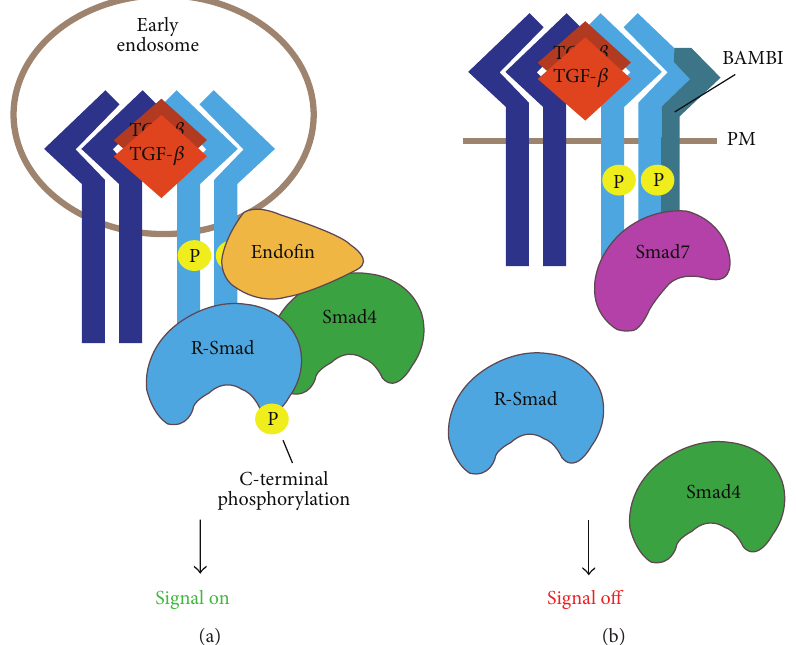
Figure 3: Modulation of Smad activation. (a) Activated T 𝛽 RI recruits and phosphorylates Smad2/3 at the C-terminal, and then the phosphorylated Smad2/3 binds Smad4 to form a Smad heterocomplex to mediate signal transduction. Endofin recruits Smad4 to the receptor complex in early endosomes and facilitates the association of receptor-activated Smad2/3 with Smad4. (b) BAMBI forms a ternary complex with receptors and Smad7 and inhibits the interaction between T 𝛽 RI and Smad3, impairing Smad3 activation. PM: plasma